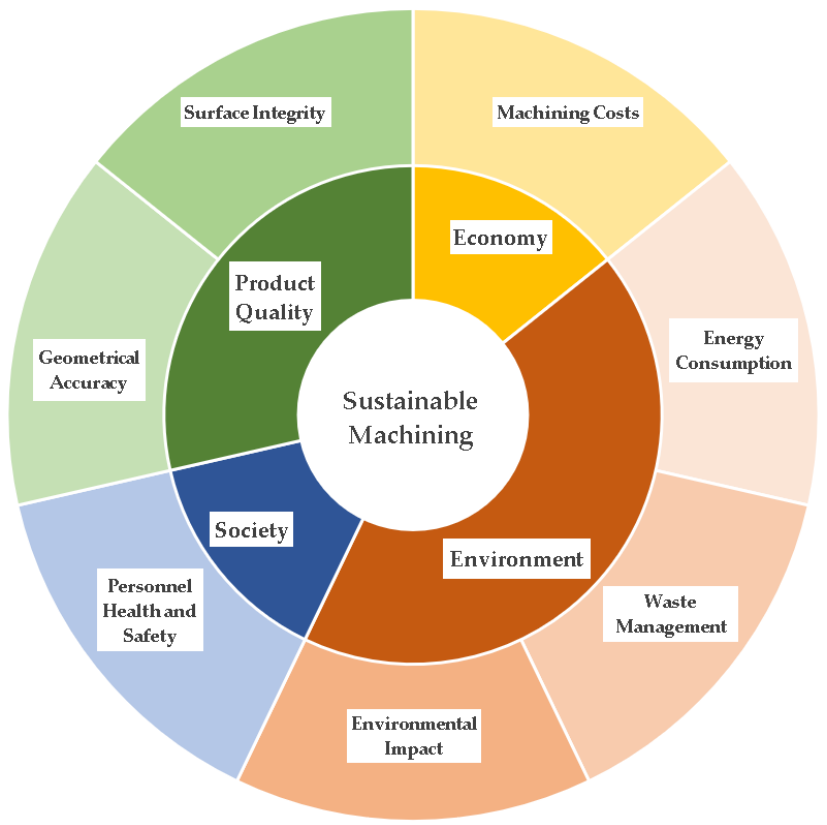
Figure 1. The primary aspects to consider during sustainable machining.